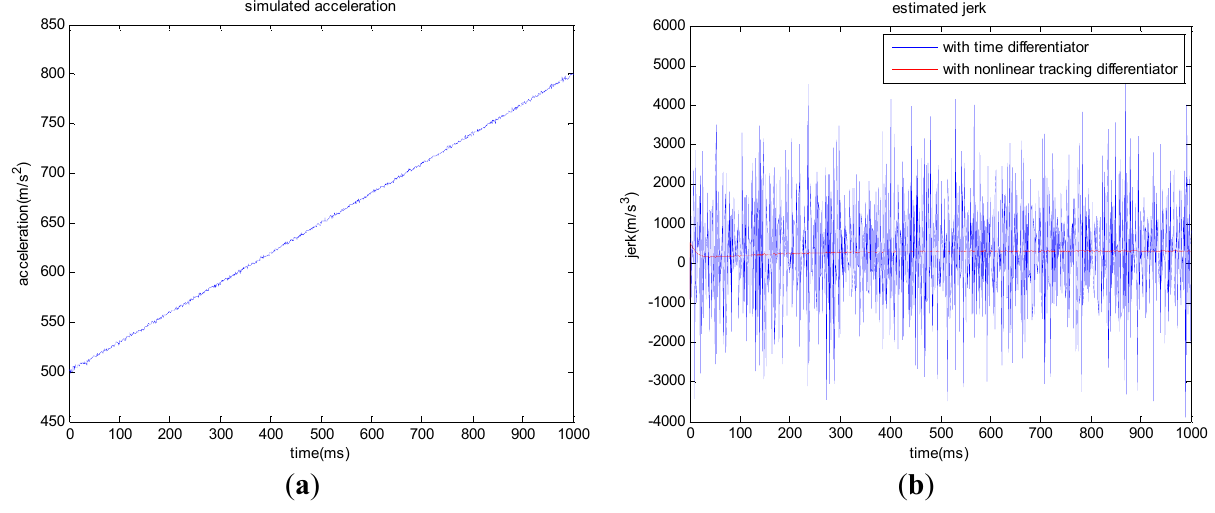
Figure 3. Jerk estimated from the simulated high dynamic acceleration with the two methods ( a ) Simulated high dynamic acceleration; ( b ) Jerk estimated with the two methods.